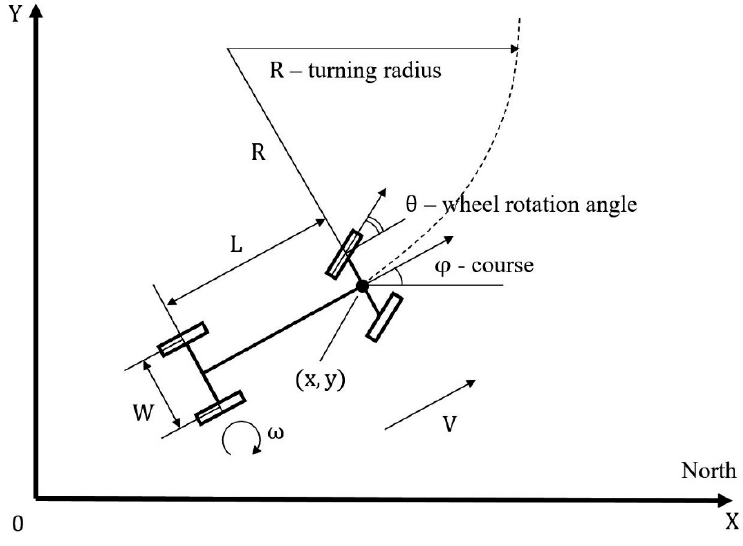
Figure 8. Designations of the spatial-angular position of the robotic platform.